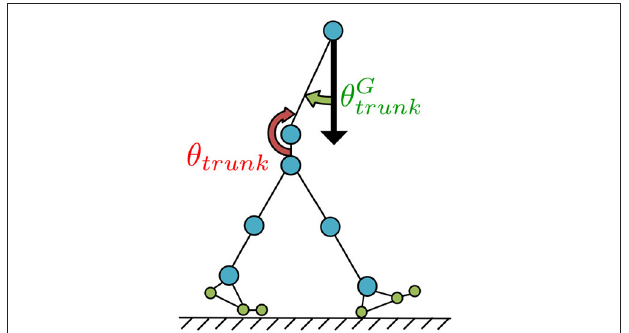
FIGURE 6 | Postural control for the trunk joint. The trunk joint was designed to be controlled such that the angle θ G trunk (angle between the torso link and direction of gravitational acceleration), which is detected by the vestibular sensor, can be accurately represented by the fixed angle α for preventing destabilising forward and backward upper-body